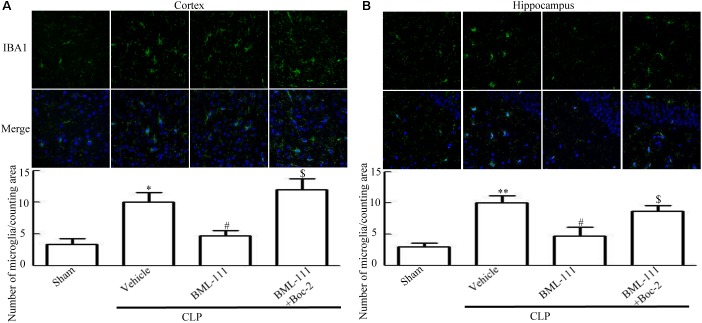
BML-111 treatment reduces the activation of microglias in CLP mice. (A,B) Activated-microglia cells were significantly increased in the CLP + vehicle group compared with the sham group. BML-111 treatment down-regulated the activated cells compared with the CLP + vehicle group, and Boc-2 reduced the effects of BML-111. Scale bars indicate 50 μm (n = 3 surviving mice per group per experiment). Data were shown as the means ± SEM. ∗P < 0.05, ∗∗P < 0.01 represent CLP + Vehicle vs. Sham, #P < 0.05 represents CLP + BML-111 vs. CLP + Vehicle, $P < 0.05 represents CLP + BML-111 + Boc-2 vs. CLP + BML-111.